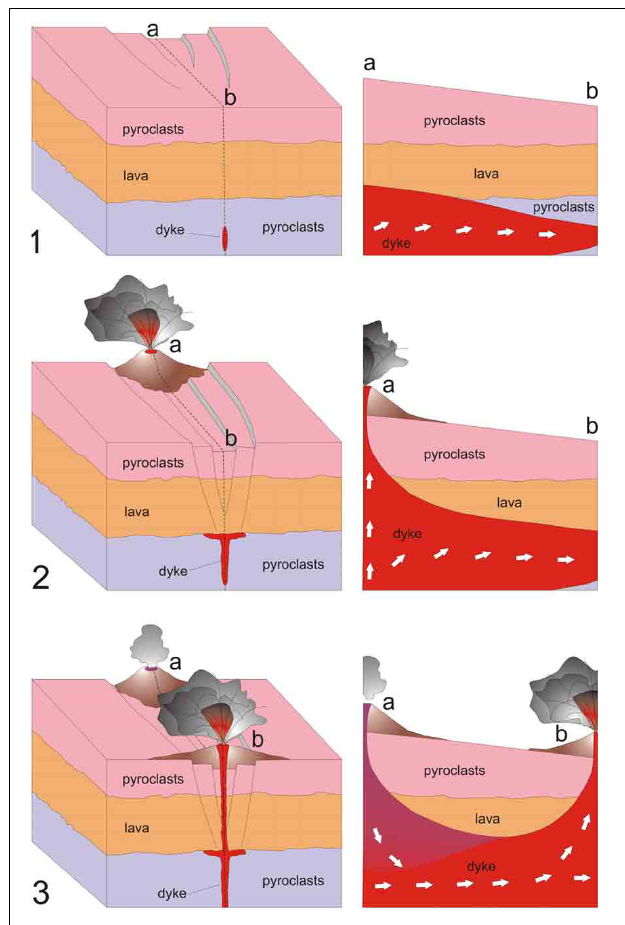
FIGURE 11 | Evolution of the central portion of the 1809 eruptive fissure system ( ∼ 2350m elevation asl). Stage 1: the eruptive fissure propagated from the Central Crater of Mt. Etna into the NE Rift; the dyke propagated at shallow level forming a graben–like structure at the surface. Stage 2: the dyke met the lava layer creating a small temporary sill, while part of the graben (at higher elevation) becomes eruptive. Stage 3: the dyke progressively propagated downslope, passing the lava layer and forming a new